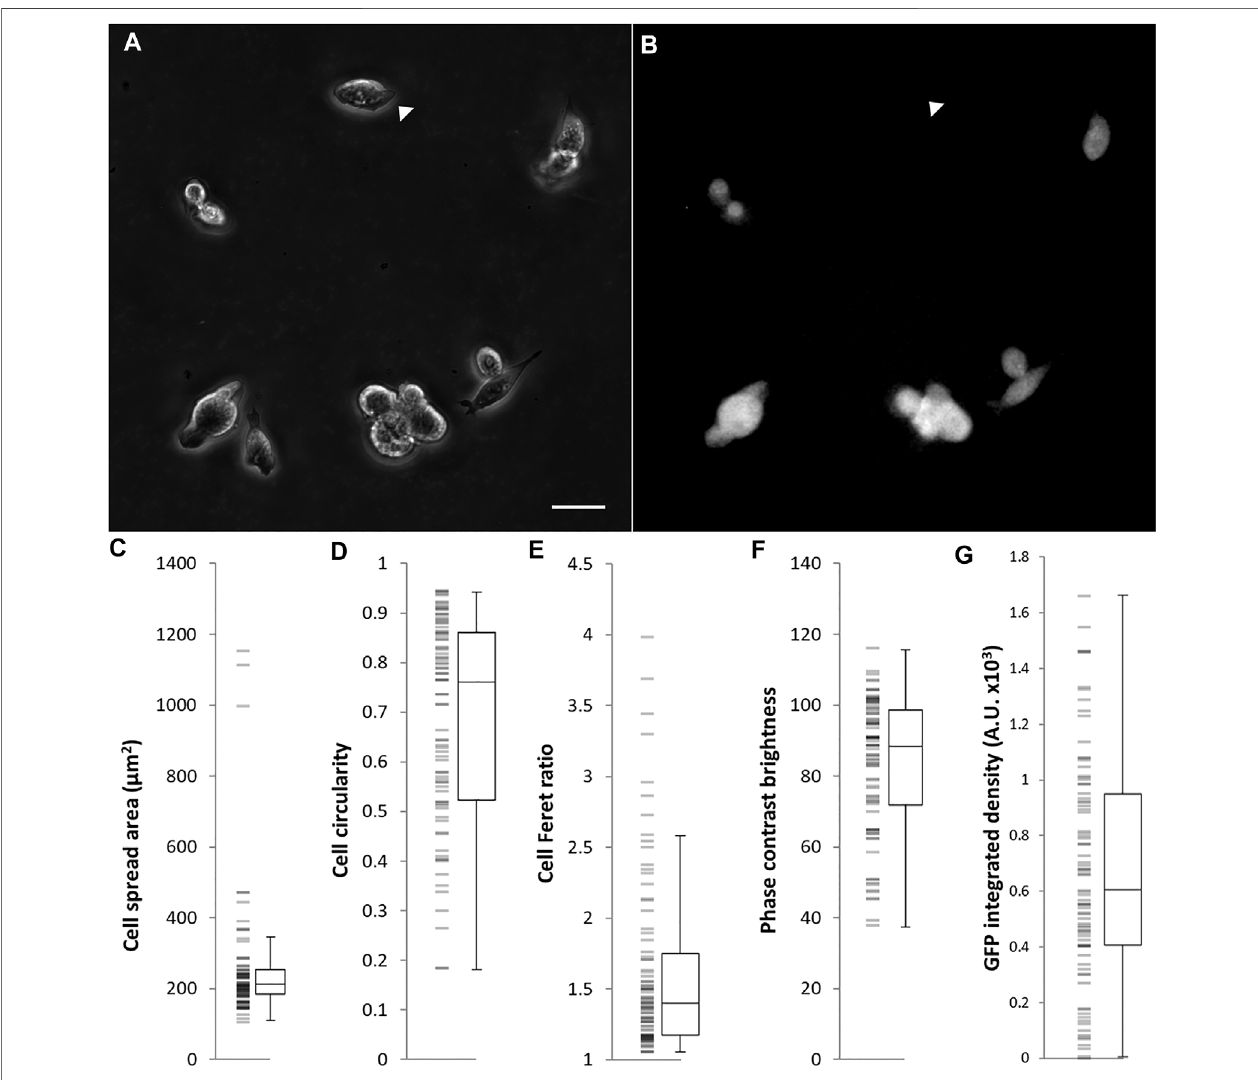
FIGURE 3 | Morphological characterization of Rex1-GFP mESCs growing in LIF/FBS medium on gelatin. Rex1-GFP cells were seeded on gelatin-coated imaging dishes, cultured for 6 h and imaged. As can be seen in the phase contrast image (A) , a range of morphologies were observed in this population. Speci fi c parameters of single cells are quanti fi ed in (C – F) . As expected, the Rex1-GFP reporter is expressed heterogeneously (B) , arrowheads indicate Rex1-GFP negative cell. Rex1-GFP is quanti fi ed in (G) . Scale bar: 25 µm. Boxes represent median and interquartile range, with whiskers extending to 1.5× interquartile range or the max/min data points. n =